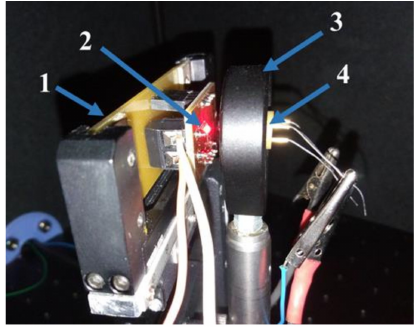
Figure 7. Optical setup for irradiance measurements. ( 1 ) LED holder, ( 2 ) LED, ( 3 ) photodiode holder, and ( 4 ) Thorlabs FDS 100-CAL Si calibrated